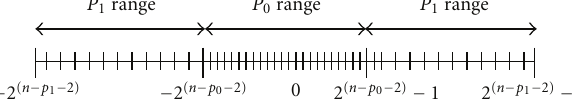
Figure 3: Range of an n p 0 p 1 DFX